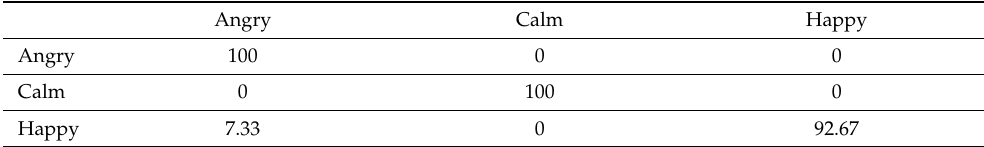
Table 4. Confusion matrix with the percentage of correctly classified samples after profile transforma- tion for each category (only correctly classified test samples). Each sample has been transformed to the profile of each class and therefore each row sums up to 100%.